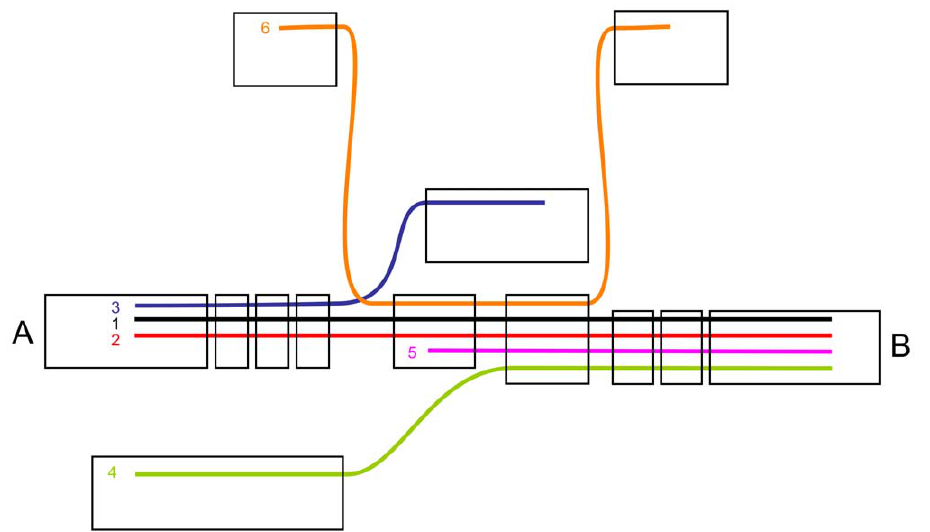
Figure 2. Resolution of repeats through the Rock Band assembly. In this simplified diagram, contigs are represented as boxes, and long reads as thick curved lines. Instead of performing a pair-wise comparison of reads, the algorithm only examines the reads going out of unique node A. Two of the reads (1 and 2) go to node B. Node 3 is disregarded because it is not confirmed by another read. The algorithm then examines the reads going into node B. They all come from node A, except read 4, which is disregarded because unconfirmed, and read 5 which is not in contradiction with the assembly of contigs A and B. Finally, read 6, despite its overlap with the other reads, is disregarded throughout the analysis, as it goes through neither nodes A nor